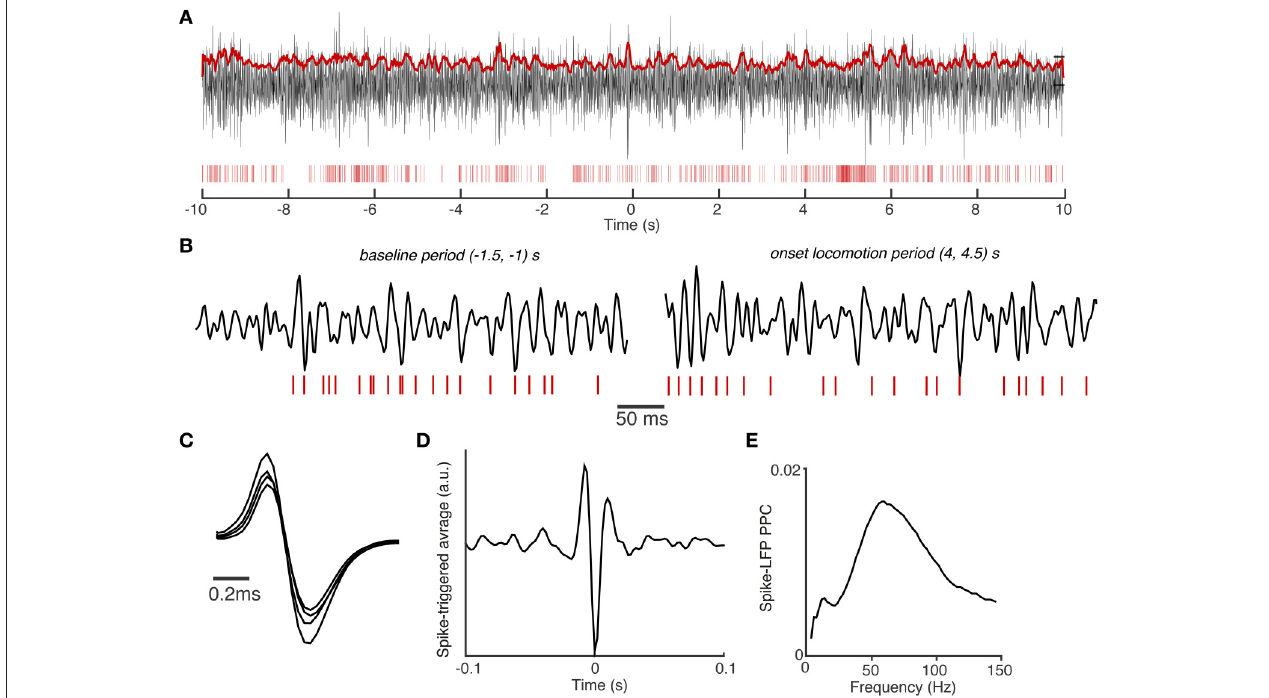
FIGURE 4 | Example of spike-field coupling in area S1BF. (A) Example trial with spike trains of an S1BF FS cell (red vertical bars) and filtered S1BF LFP trace (30–120Hz). LFP was recorded from another tetrode than the FS cell, positioned in the same layer and was roughly 0.4mm away. Both electrodes were positioned in layers 2/3. LFP has trace plotted in arbitrary units. Red continuous trace: the 100ms average of the Hilbert amplitude envelope of the filtered LFP signal. Note that the FS fires at high rates that are characteristic for GABAergic interneurons. t = 0 corresponds to onset of visual cue. (B) Shown are different periods of trace in (A) with higher temporal resolution. All LFPs on the same scale (arbitrary units). (C) Average spike waveforms for the FS cell. Note the different waveform amplitudes recorded on the four different leads of the tetrode. (D) Average spike-triggered-average LFP over entire task period, filtered in 30–120Hz band (arbitrary units). The spike-triggered-average LFP decorrelates quickly over time, reflecting the broad-band nature of spike-LFP locking. (E) Spike-LFP PPC spectra for the FS cell measured entire task period.